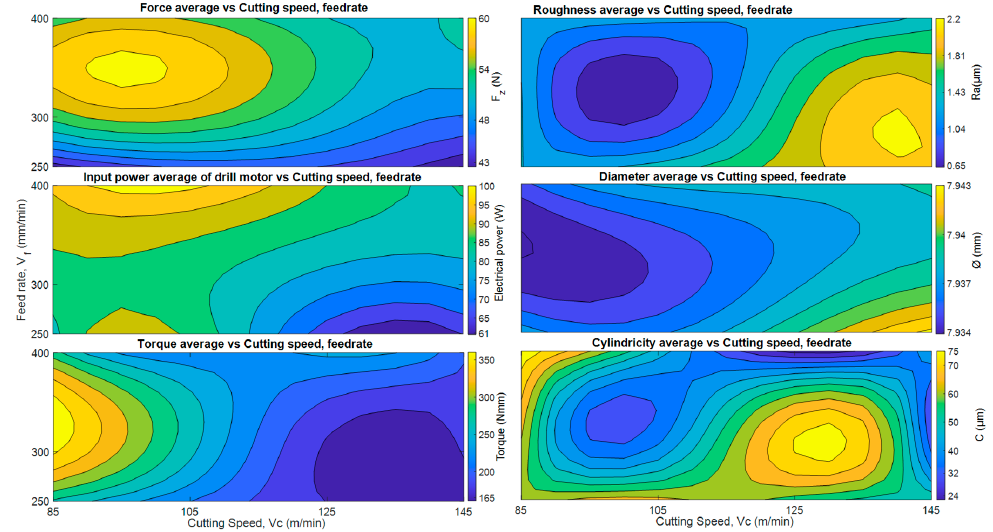
Figure 11. Average thrust force, torque, electric power, roughness, cylindricity and diameter. The best average values of -roughness, cylindricity and diameter-, are given in the area around v c = 105 m/min and v f = 300 mm/min, corresponding to f = 0.07 mm/rev. However, the lowest values of thrust force, torque and energy consumption, occur in the area between v c 125–145 m/min and v f values of roughness, diameter and cylindricity.